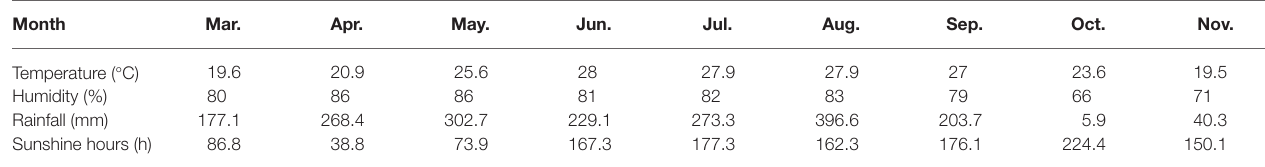
TABLE 2 | The meteorological data of the experimental site during the early and late seasons of the double rice cropping system in South China. Month Mar. Apr. May. Jun.